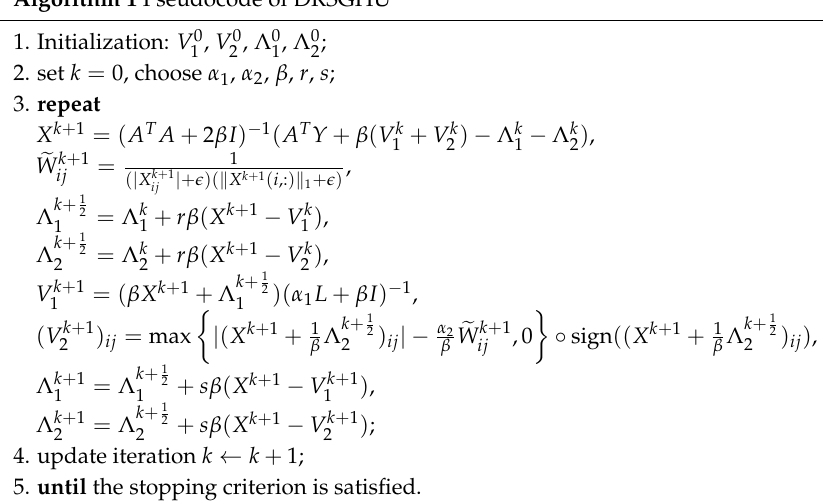
Algorithm 1 Pseudocode of